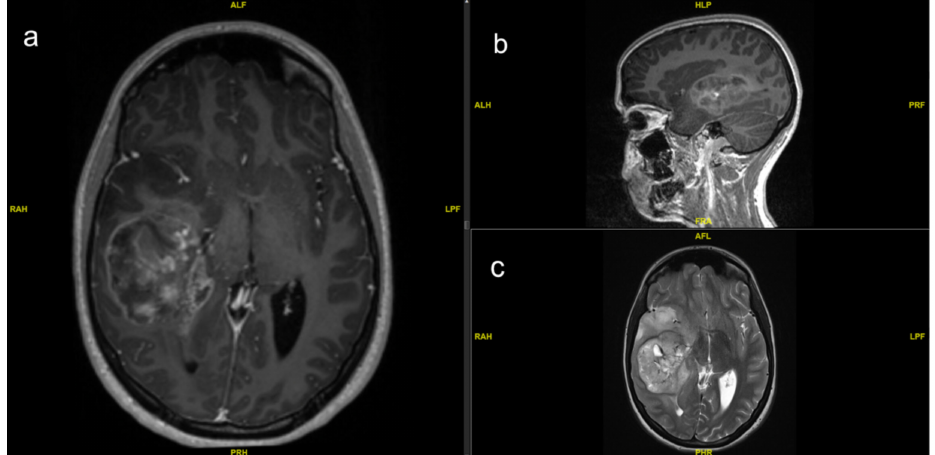
Figure 1. Preoperative MRI of a 14-year-old girl with right temporal GBM with heterogeneous enhancement in ( a ) axial and ( b ) sagittal T1-weight with contrast agent. The tumor mass causes a midline shift and shows central enhancement. ( c ) Axial T2-sequence with hyperintense signal of infiltrating tumor mass peripheral to enhancing center in the mesial and temporopolar